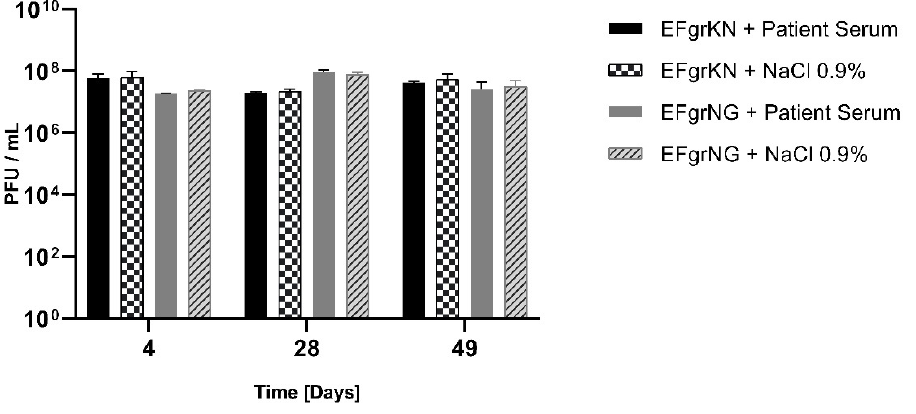
Figure 2. Phage neutralization assay was performed in triplicate on serum samples of the patient collected on days 4, 28 and 49 after initiation of phage therapy with the phages EFgrKN and EFgrNG. The resulting phage activity, after incubation with the serum samples, was expressed in PFU/mL and compared to a control consisting of phage particles in NaCl 0.9%, after incubation at 37 °C for 30 min. Results are plotted as mean ± SD. At no time point could relevant differences in phage titers, which would indicate neutralizing activity of patient serum, be observed.